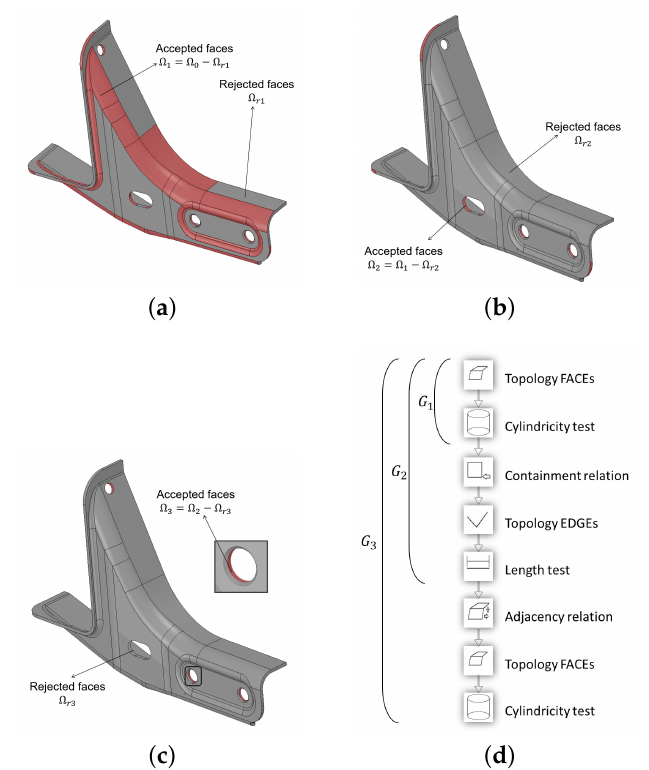
Figure 14. Results of Example 1: recognition of hole feature in data set 1 (see Ref. [2] from same authors). ( a ) Reduced domain Ω 1 ⊂ Ω 0 , ( b ) Reduced domain Ω 2 ⊂ Ω 1 , ( c ) Reduced domain Ω 3 ⊂ Ω 2 , and ( d ) Search graphs G 1 , G 2 and G 3 .